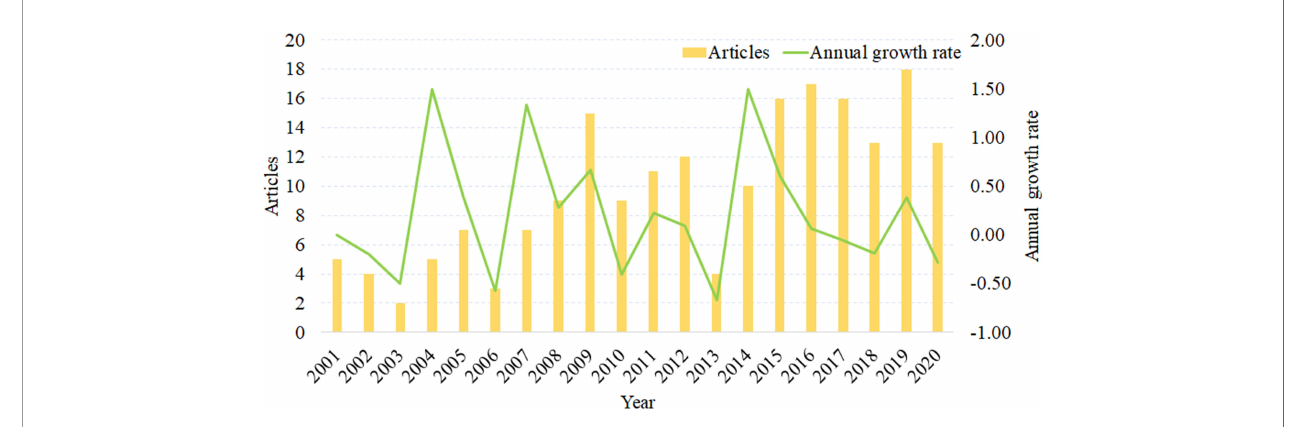
( Figure 3 ). Global collaborations among countries and regions are presented in Figure 4A .